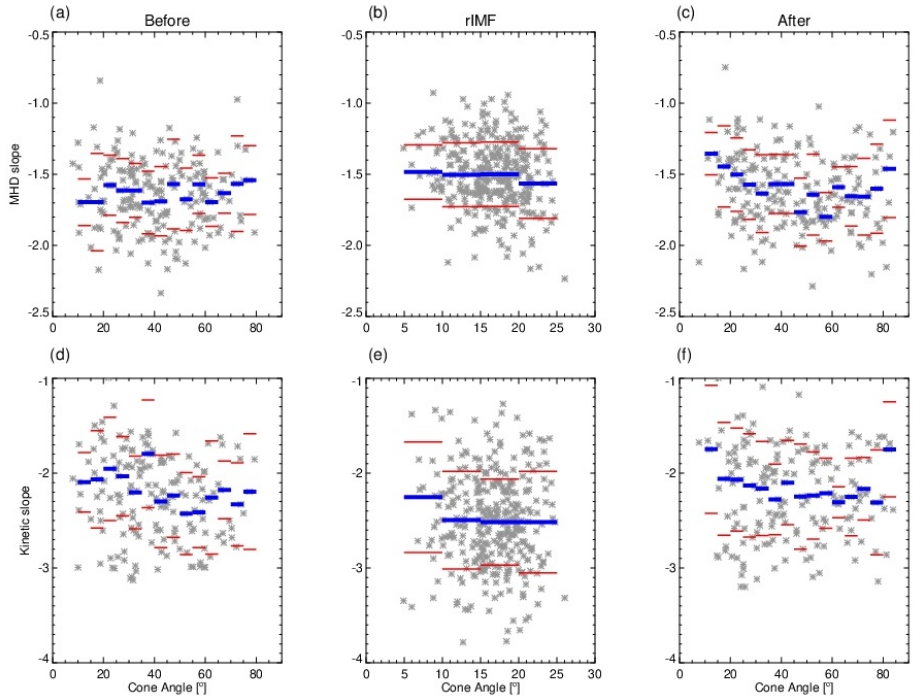
Figure 10. Scatter plots of the PSD slopes as a function of the cone angle with the same format as Figure 9: ( a ) in the region before the radial IMF events, ( b ) in the radial IMF events, and ( c ) after the events in the MHD ranges and the same plots ( d ) in the region before the radial IMF events, ( e ) in the radial IMF events, and ( f ) after the events in the kinetic ranges.